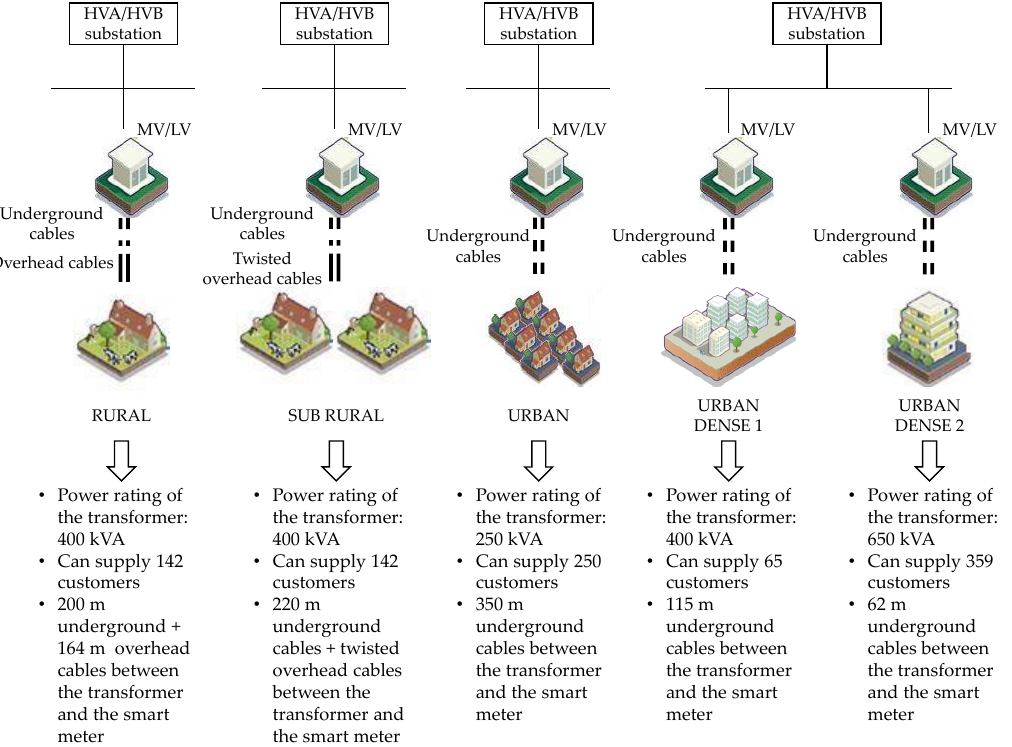
Figure 3. Five measurement sites in various locations of the city of Tours in France.